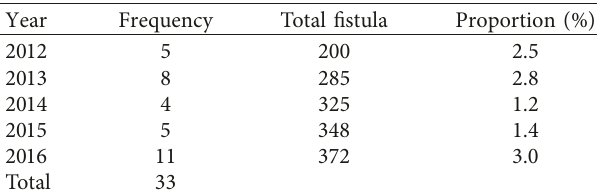
Table 2: Ureteric pathology annual